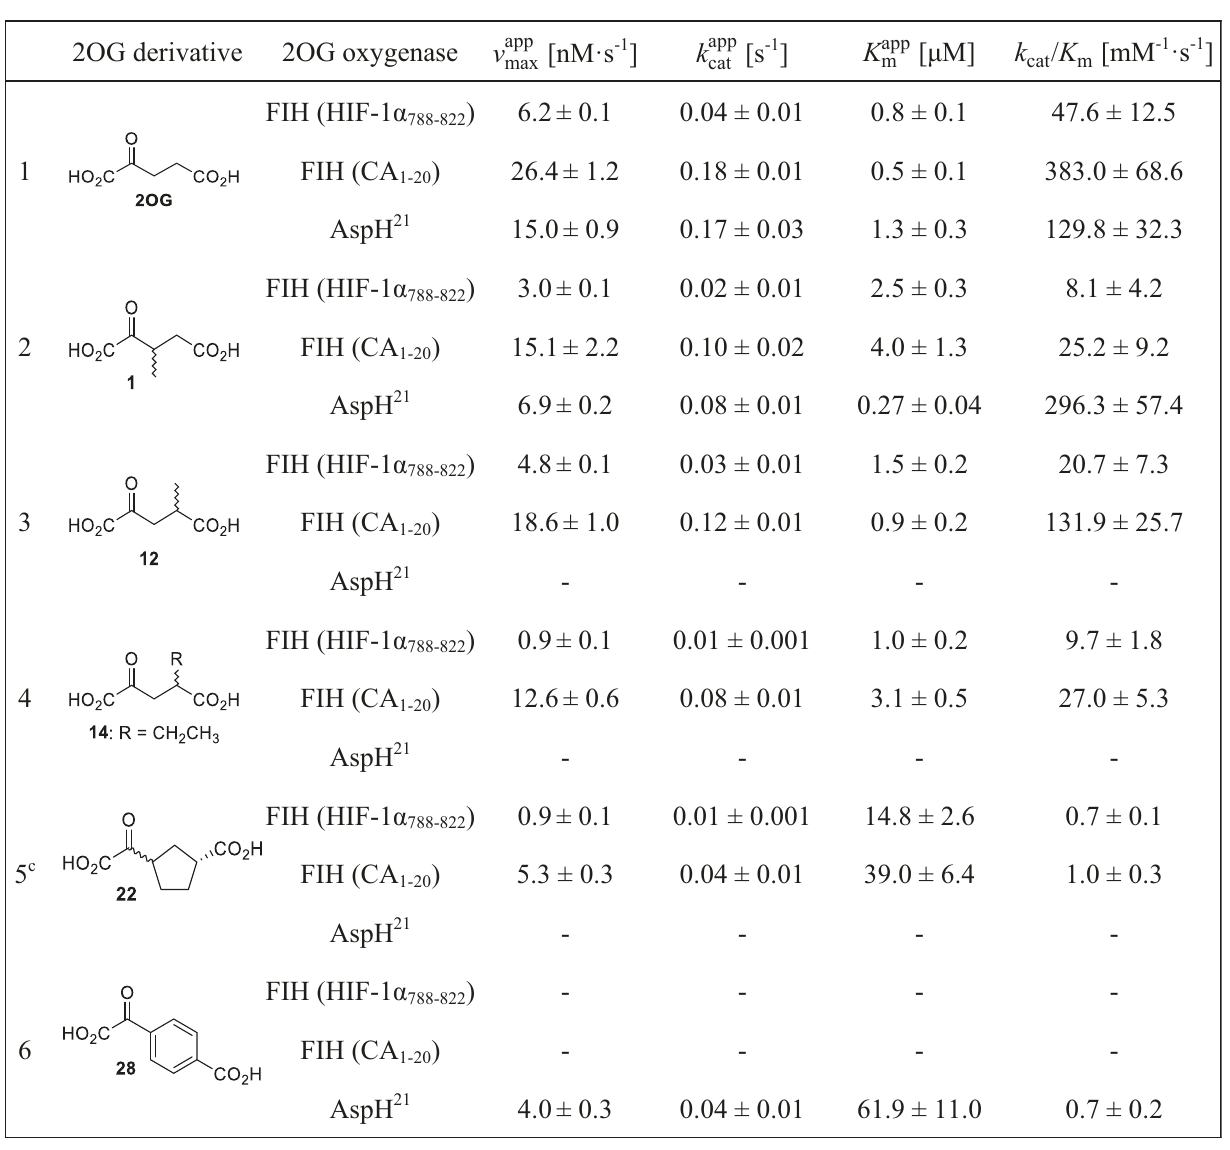
Table 2 Comparison of the steady-state kinetic parameters of FIH for 2OG and the synthetic 2OG derivatives 1, 12, 14, and 22 with those reported for AspH a,b